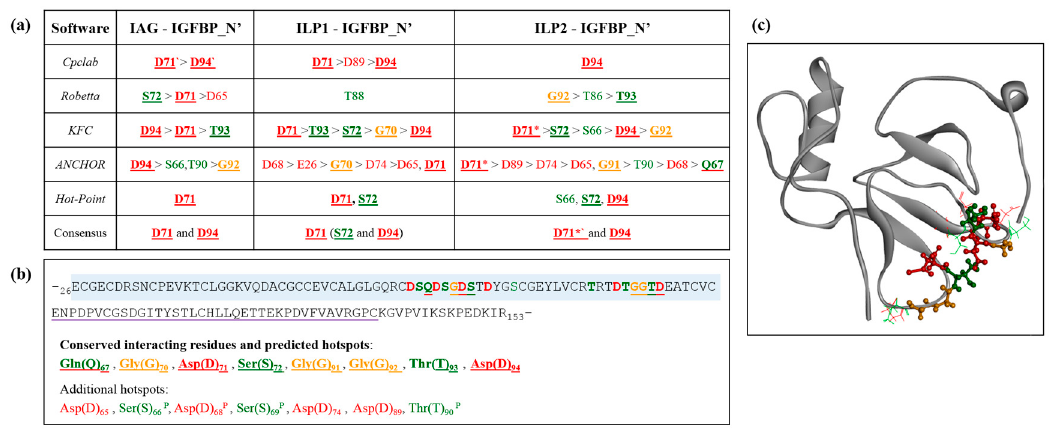
Figure 6. Identification of hotspot residues: ( a ) determined by five independent alanine scanning algorithms. Amino acids are shown in standard letter notation. Other notation is as follows: an asterisk (*) indicates the presence of a salt bridge predicted by PDBsum; a dash (‘) a salt bridge predicted by Cpclab; bold underlined indicates residues that show a conserved binding interaction with all three ligands (see Figure 5b). ( b ) Illustration of Sv-IGFBP_N’ sequence (insulin-binding domain boxed in blue and kazal domain underlined in purple) highlighting the positioning of predicted hotspots. The eight consistently interacting hotspot residues are in bold underline. Additional predicted hotspots are also listed, with a P highlighting those residues that were predicted as consistently interacting residues by PRODIGY. ( c ) Structural illustration of Sv-IGFBP_N’ with conserved interacting hotspot residues highlighted in ball and stick and additional hotspots in stick. Throughout, red indicates negatively charged residues; green, neutrally charged; and orange, glycine. Note the neutral Gln(Q) has been underlined in red in ( b ) sequence and coloured red in ( c ) structure due to its role in stabilizing the overall negative charge through the formation of hydrogen bonds.